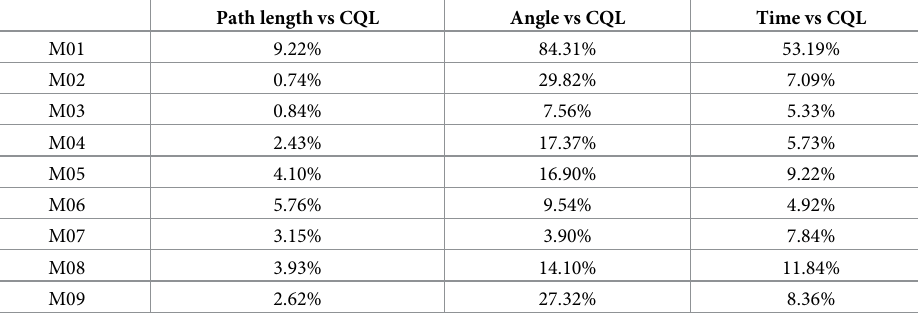
Table 5. Comparison of algorithm performance between SSQL and CQL in safe path